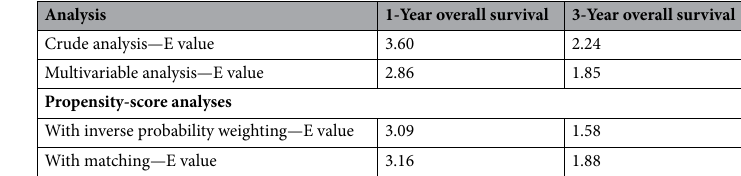
Table 6. Evaluation for unmeasured confounding between SLNB groups by E-value analysis. The larger the E-value, the lower the probability that an unmeasured confounder was to explain the entirety of the treatment